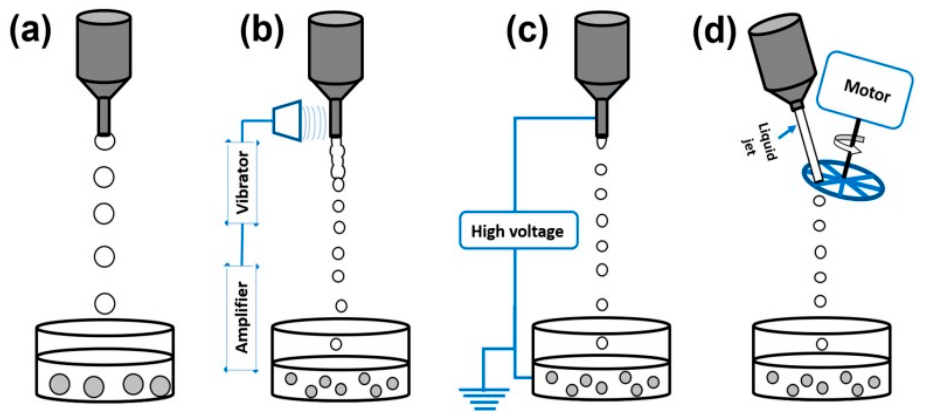
Figure 4. Illustration of dropping devices: ( a ) conventional dropping method influenced by gravity, surface tension, and viscosity; breaking up of liquid jets into droplets stimulated by ( b ) vibrating nozzle method, ( c ) electrostatic forces, and ( d ) a mechanical cutting device [37].